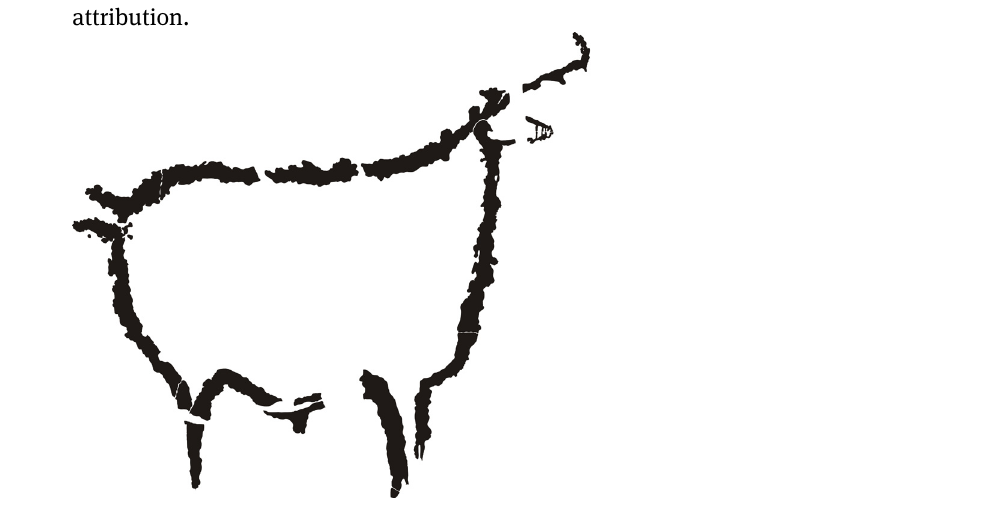
Figure 11. Chamois depiction in Fariseu Rock 1, Côa Valley, Portugal. Tracing: Fernando Barbosa, assisted by Manuel Almeida, João Félix and André Tomás